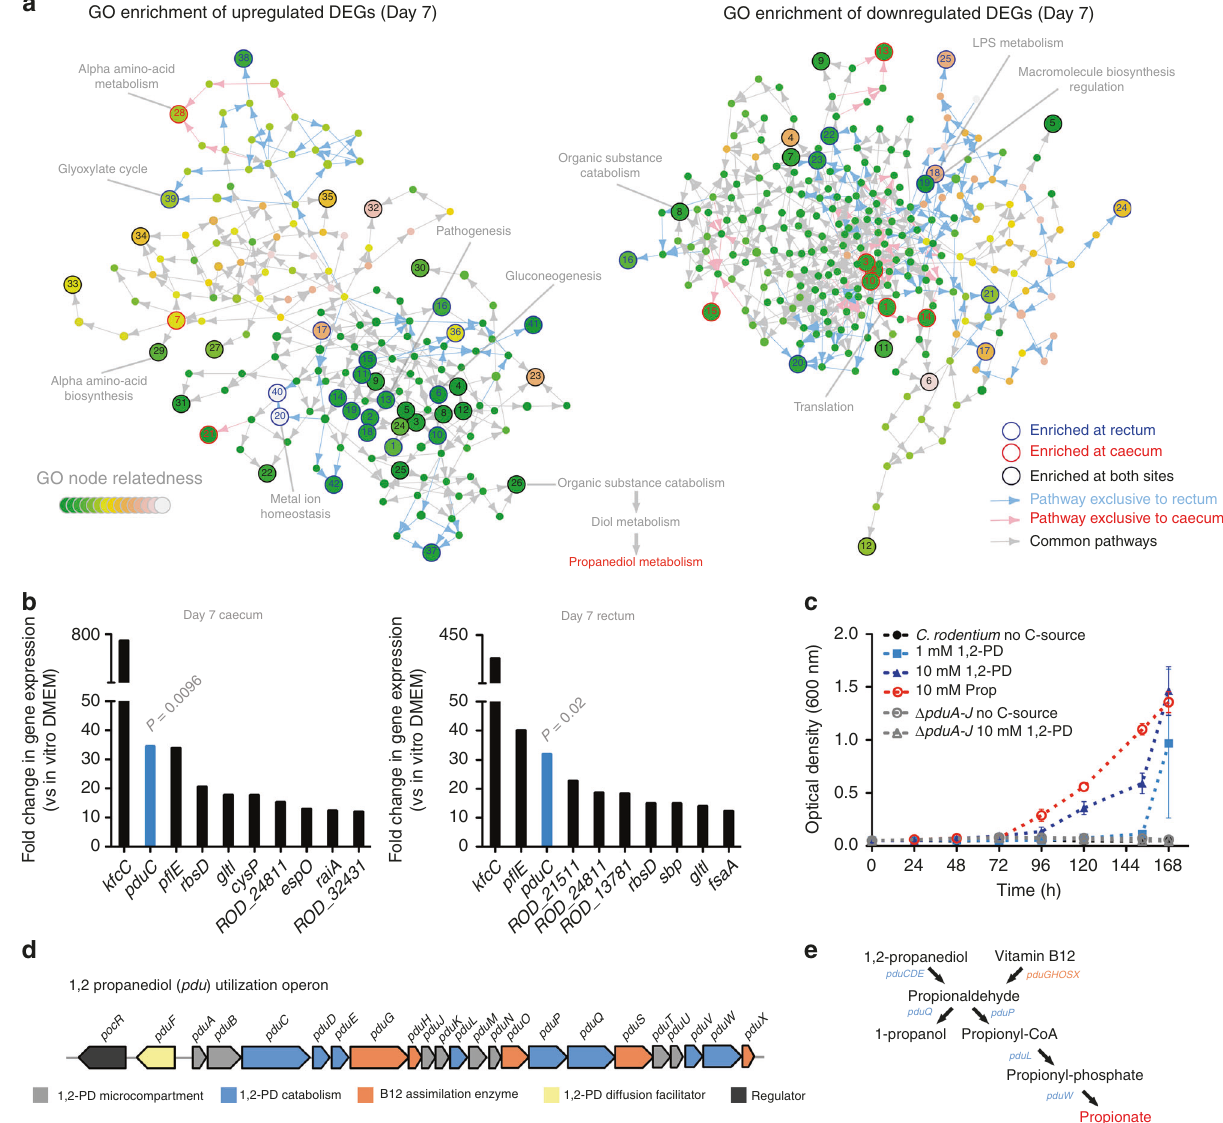
Fig. 4 Host-associated C. rodentium metabolism co-ordinated with infection. a Networks graphs illustrating the identi fi cation of gene ontology (GO) terms in vivo relating to Supplementary Data 4. Networks were generated for both upregulated and downregulated genes individually. Coloured nodes represent GO terms associated with the DEGs in vivo and the arrows indicate relatedness to one another by distance. Signi fi cantly enriched GO terms ( P ≤ 0.05) were assigned a numbered node and each node is colour-coded to represent enrichment of a biological function at the caecum (red), the rectum (blue) or at both sites (black). The identi fi cation of 1,2-propanediol as a signi fi cantly enriched biological process in vivo is indicated at node 26. The colour coding of related nodes is indicated on the inset legend. b The top 10 DEGs identi fi ed at peak infection according to fold increase in expression (EDGE test). Genes from the pdu operon (1,2-propanediol metabolism) are highlighted in blue and the relative EDGE test P -value indicated above. Each bar represents the mean of 3 biological replicates. c Growth of C. rodentium and Δ pduA-J with 1,2-propanediol (1,2-PD) or propionate (Prop) as a sole carbon source. Data points indicate the mean optical density measurements (600 nm) of three biological replicates ± SEM. d The C. rodentium pdu operon. Genes are colour-coded according to role in 1,2-propanediol metabolism. The fi gure is adapted from Sturms et al. 80. e Schematic depiction of the 1,2-propanediol metabolic pathway. The intermediate products and genes involved in their generation are